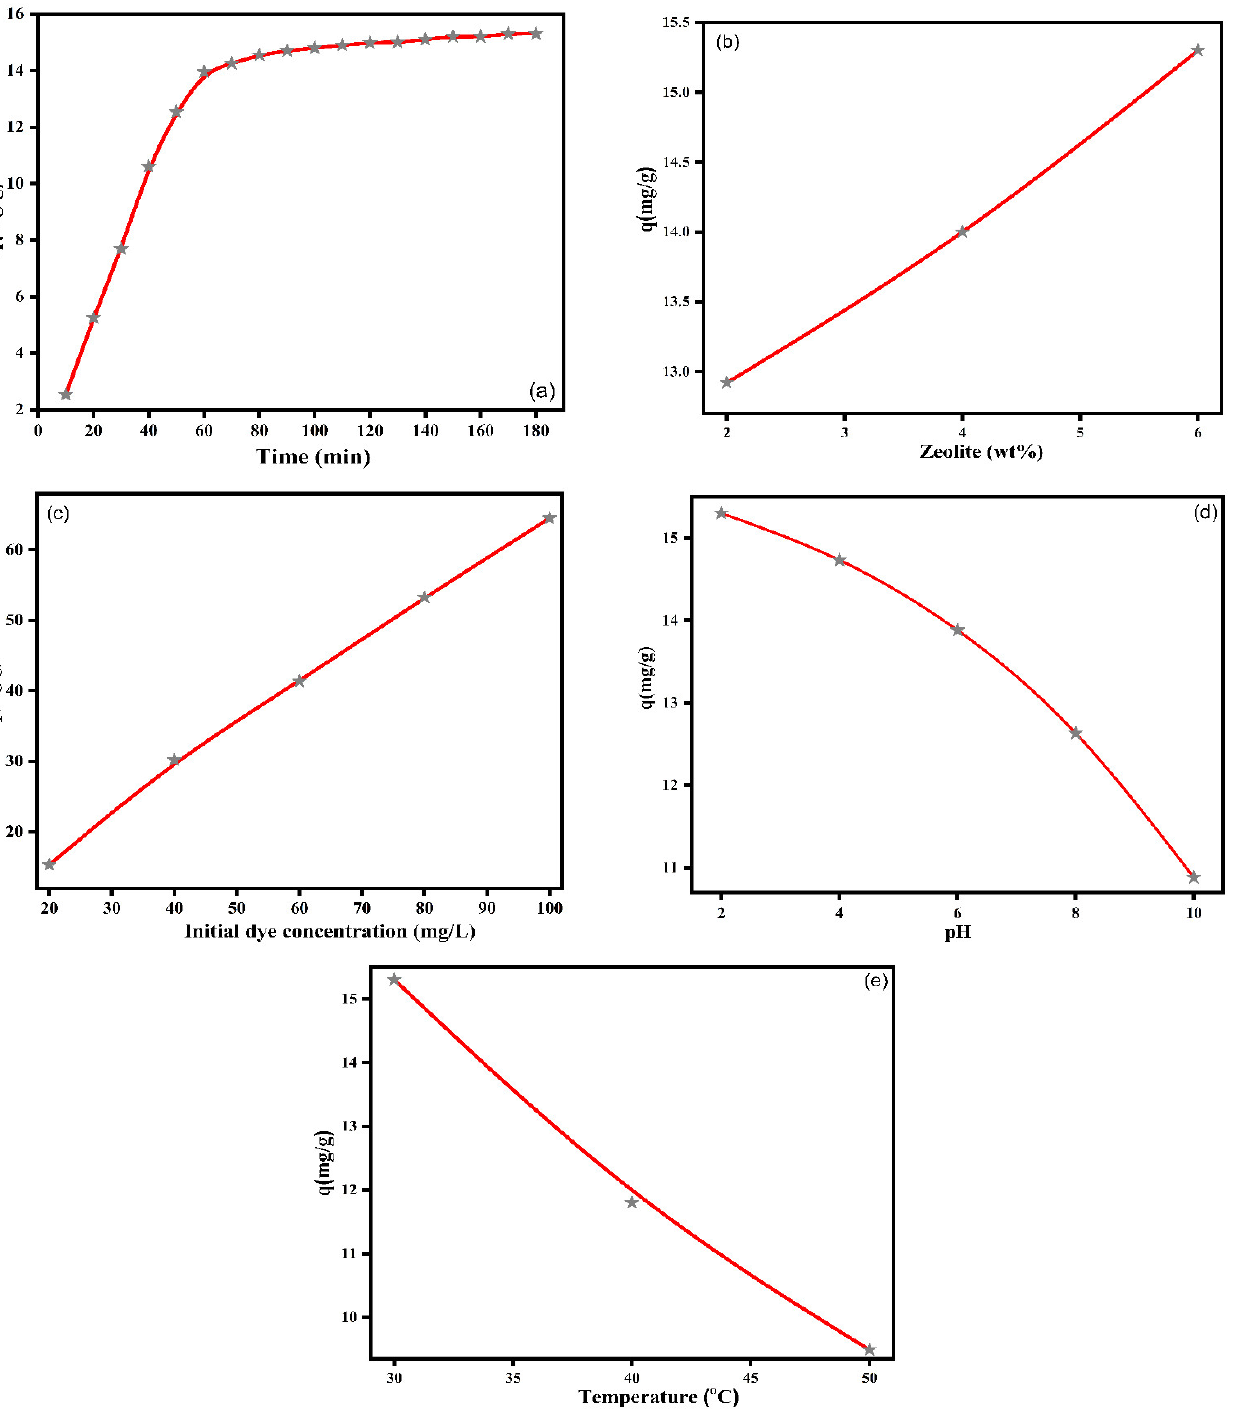
Figure 9. Effect of contact time ( a ), adsorbent loading ( b ), dye concentration ( c ), pH ( d ) and temperature ( e ) on CR uptake capacity (experimental condition: adsorbent dosage 6 wt%, concentration of CR solution 20 mg L −1 , pH 2, contact time 3 h and temperature 25 °C).